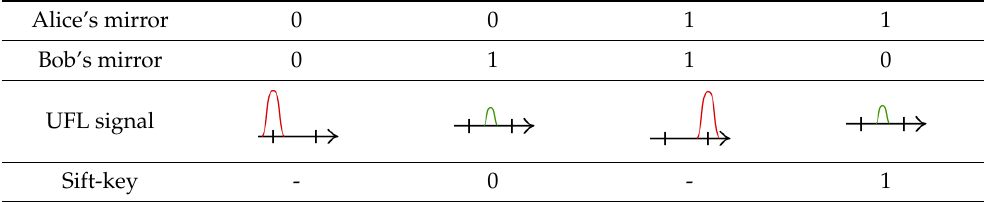
Figure 1. ( a ) Experimental setup; ( b ) internal schematic of the bidirectional EDFA utilized. Table 1. Protocol for a key distribution system using an ultra-long fiber laser. Only when Alice and Bob choose different mirror states are the bits kept in order to obtain the sift-key.